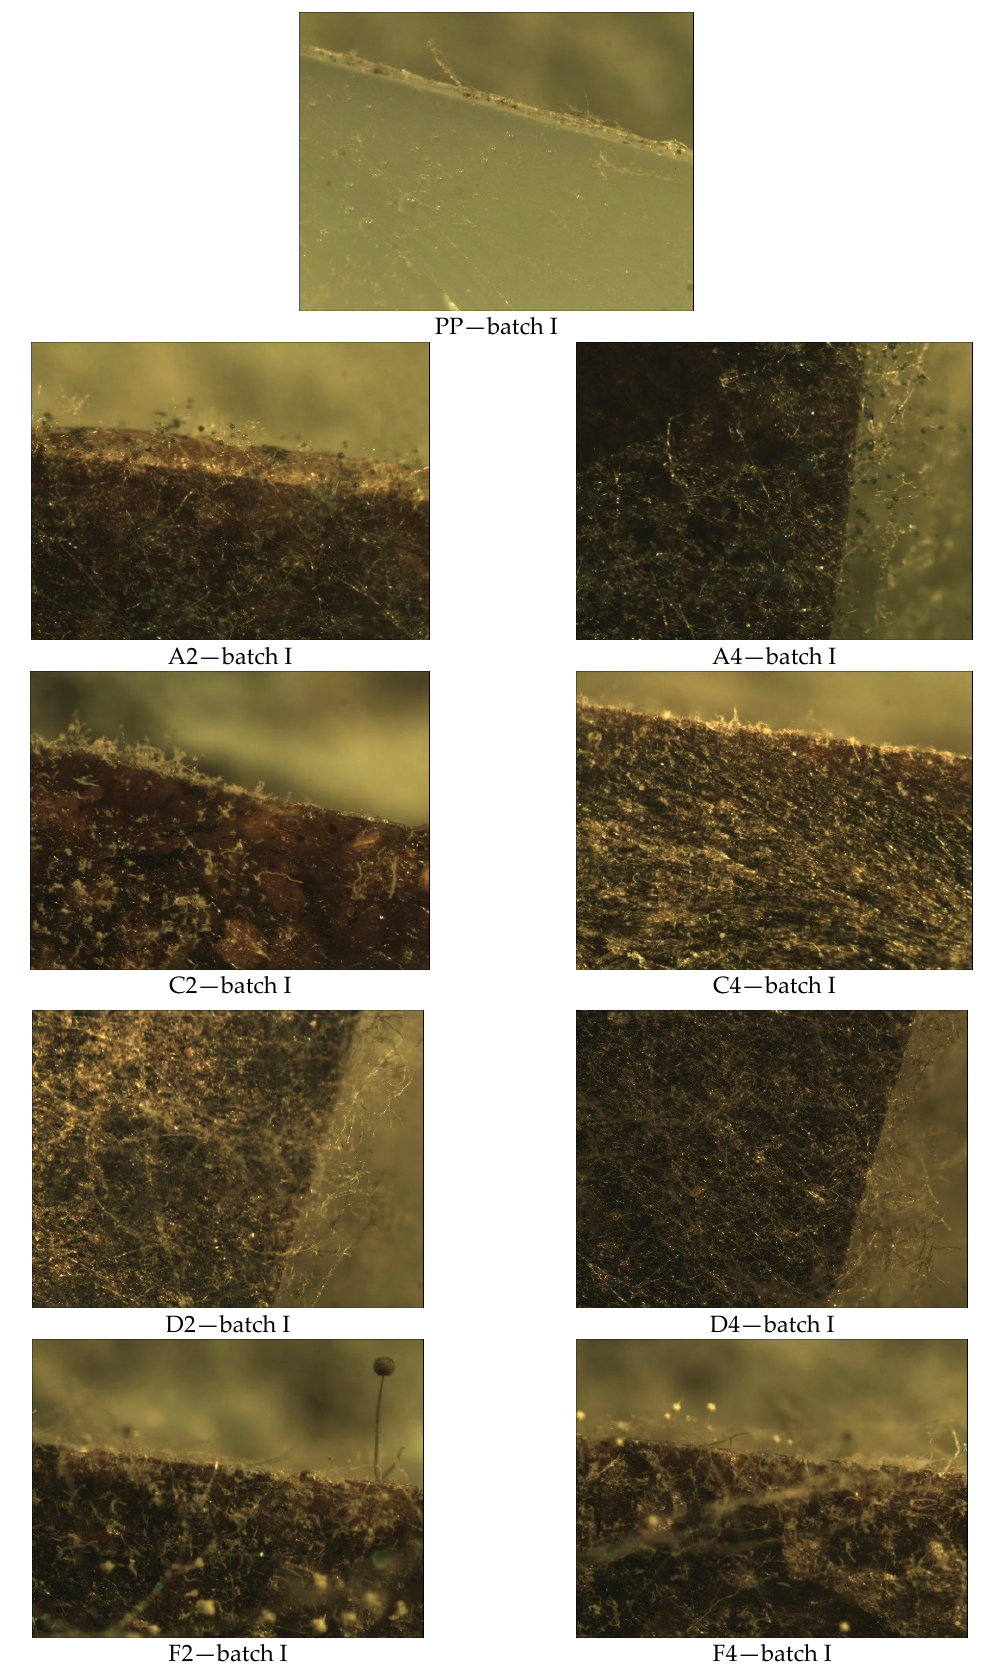
Figure 8. Methods B—results of microscopic evaluation of batch samples: